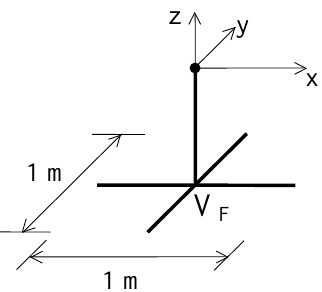
Figure 3. Three-dimensional geometry of the passive GS.